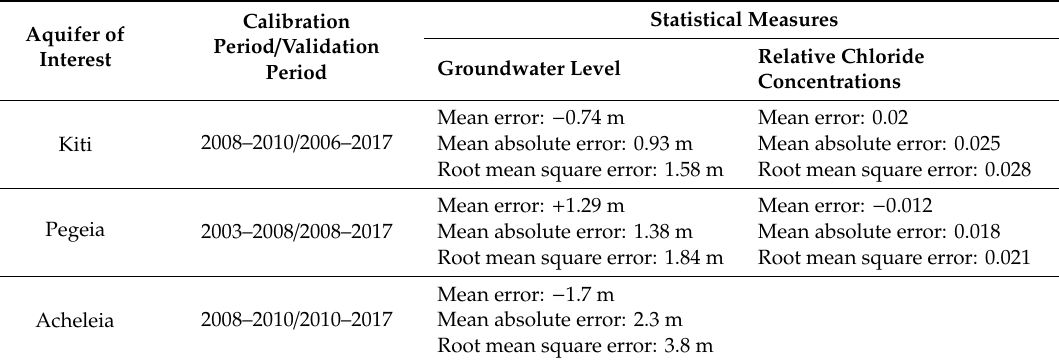
Table 3. Validation metrics of simulated groundwater levels and chloride concentrations at monitoring